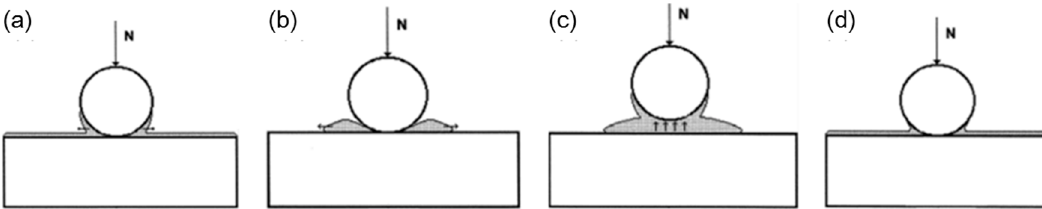
Figure 17. ( a ) Four possible models of existence of water layer between contacting interface. ( a ) Hydrophilic asperity contacting with hydrophilic substrate. ( b ) Hydrophobic asperity contacting with hydrophobic substrate. ( c ) Hydrophobic asperity contacting with hydrophilic substrate. ( d ) Hydrophilic asperity contacting with hydrophobic substrate. Reprinted from Ref. [102], Copyright 1998, with permission from Elsevier.